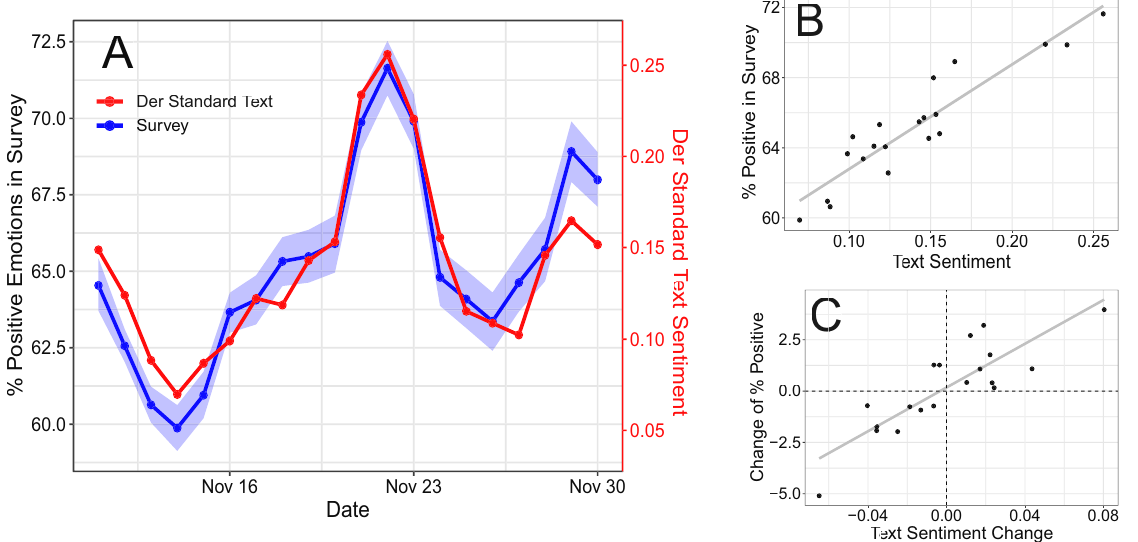
Figure 1. ( A ) Time series of the daily percentage of positive mood reported in the survey and the aggregated sentiment of user-generated text on derstandard.at. The shaded blue area corresponds to 95% bootstrapped confidence intervals. ( B ) Scatterplot of text sentiment and survey responses with regression line. ( C ) Scatterplot of the daily changes in both text sentiment and survey responses compared to the previous day, with regression